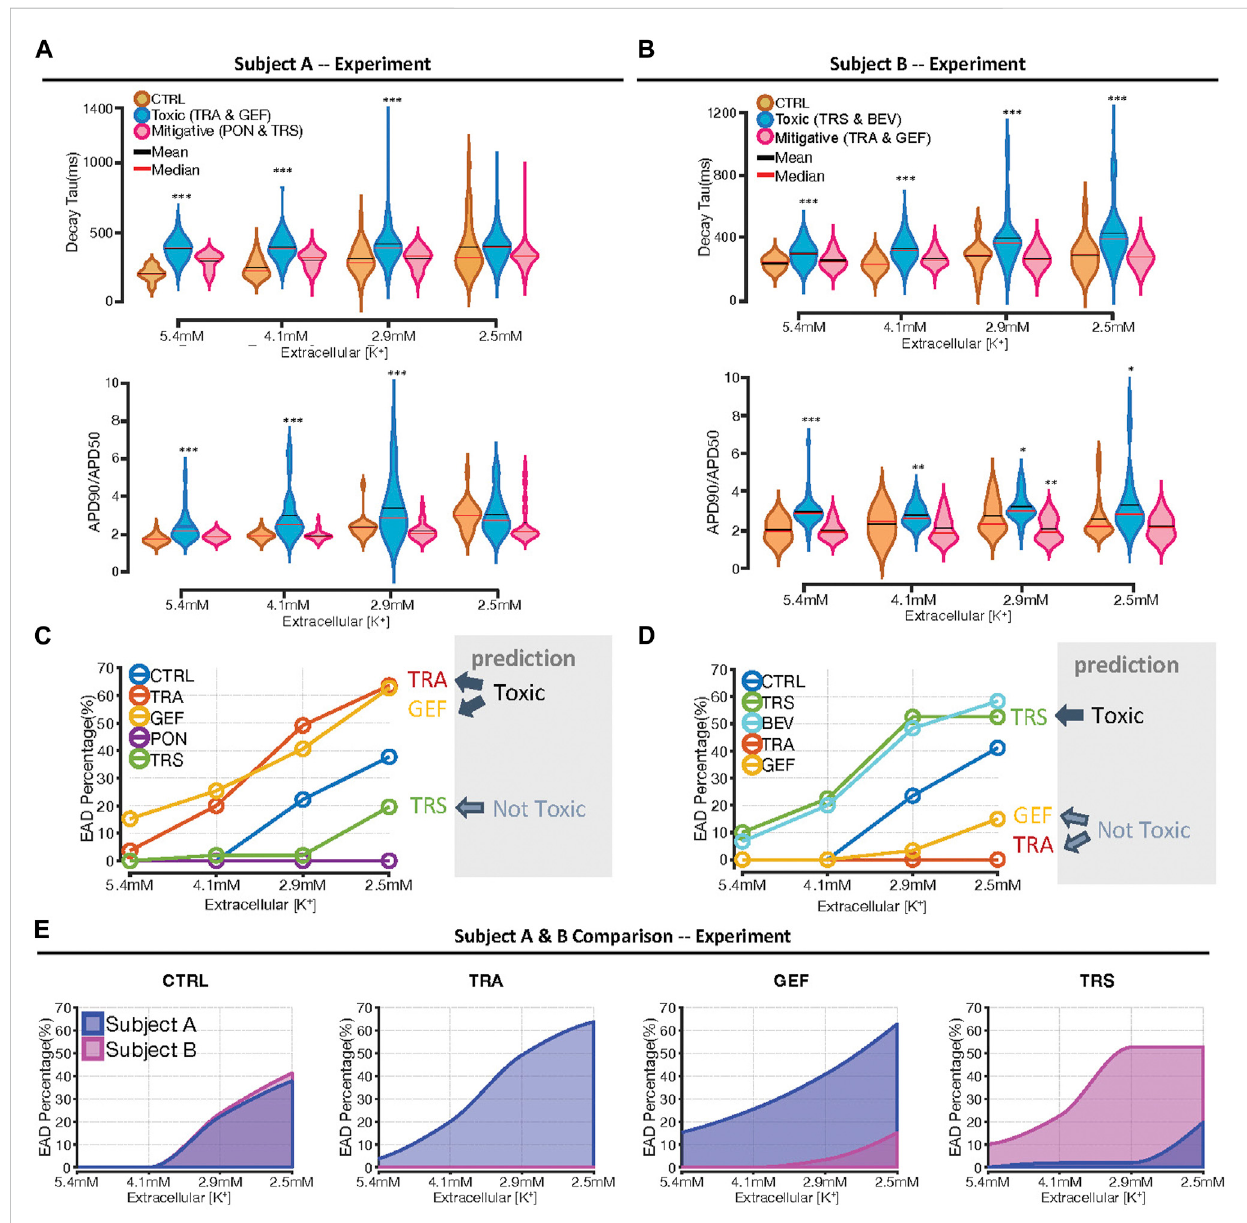
FIGURE 5 Summary data indicating differential response to hypokalemia between cell lines. (A, B) Violin plots indicating the distributions of Decay Tau (top plots), and AP triangulation (bottom plots), as a function of extracellular [K + ], in Cell Lines A and B, respectively. To facilitate statistical comparisons, drug treatments are grouped as either “ toxic ” drugs or “ mitigative ” drugs predicted to increase or decrease susceptibility, respectively. Asterisks indicate conditions statistically different from vehicle-treated control cells at the same level of extracellular [K + ], using a two sample, unpaired t -test (* p < 0.05, ** p < 0.01 and *** p < 0.001). (C, D) Percentage of samples exhibiting arrhythmic dynamics, as a function of extracellular [K + ], in Cell Lines A and B, respectively. Drugs predicted to be toxic, namely, trametinib and ge fi tinib in Cell Line A, and trastuzumab and bevacizumab in Cell Line B, exhibited